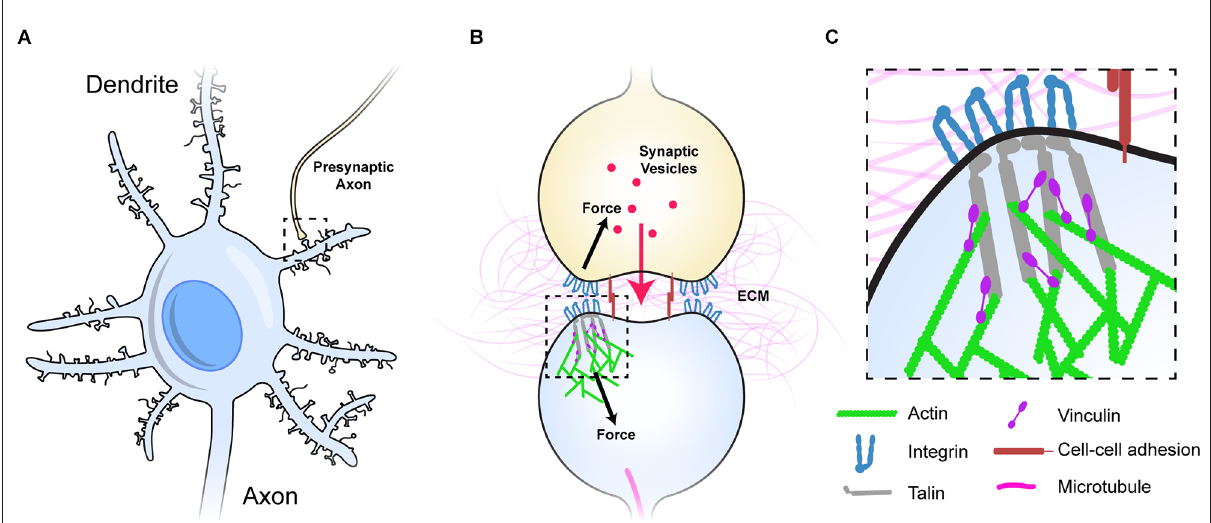
FIGURE1 Dendritic spines as mechanical units. (A) A neuron with multiple dendrites branching from the cell body, each with 100s of dendritic spines (light blue), each of which forms a synapse with an axon of another neuron and receives signals from that neuron. One such connection is shown to an axon from another neuron (yellow). (B) Typical representation of a dendritic spine showing the pre- (yellow), and post-synaptic (light blue) neurons forming the chemical synapse. The pre- and post-synaptic neurons are mechanically linked, both by sharing the same ECM across the synaptic cleft, but also by cell-cell adhesion complexes (red), these couplings inextricably link the two sides of the junction. (C) The integrin- talin-actin linkages that define the MeshCODE are shown. Talin (grey) connects the integrin-ECM complexes to the force-generation machinery (green). Vinculin (purple) cross links talin to actin and stabilises the complexes. Figure is not drawn to scale.